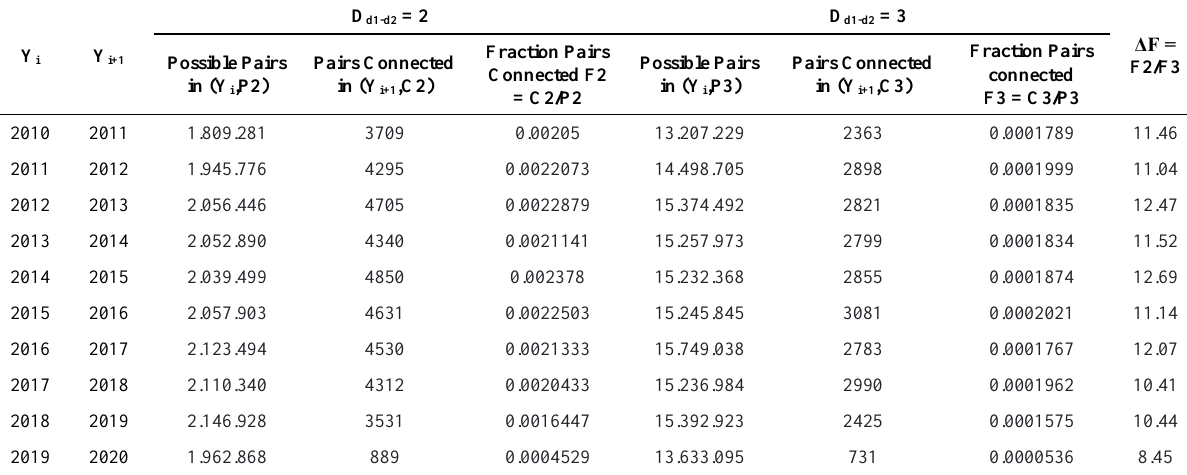
Table 2. Cyclic Closure Bias Evaluation in